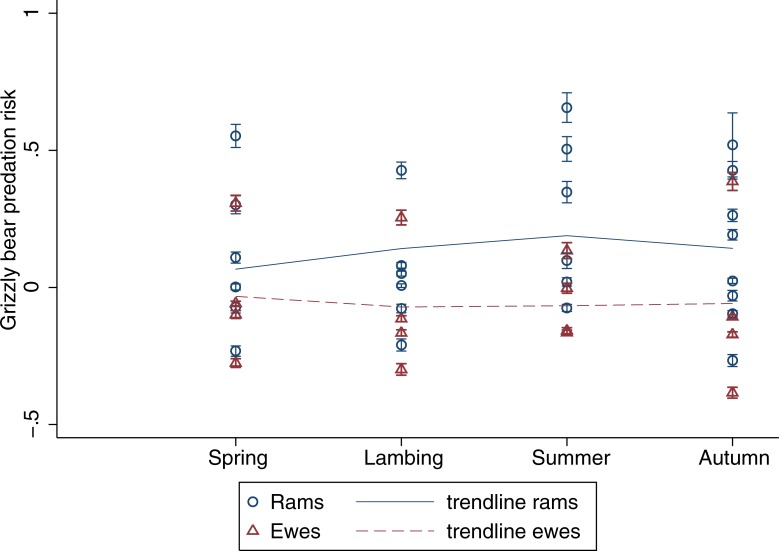
Regression coefficients representing seasonal exposure to grizzly bear predation risk for individual Dall sheep rams and ewes, calculated from the composite seasonal home range of all collared grizzly bears within the study area.Error bars on each data point correspond to the 95% confidence interval. A fractional polynomial trendline for rams and ewes is shown.